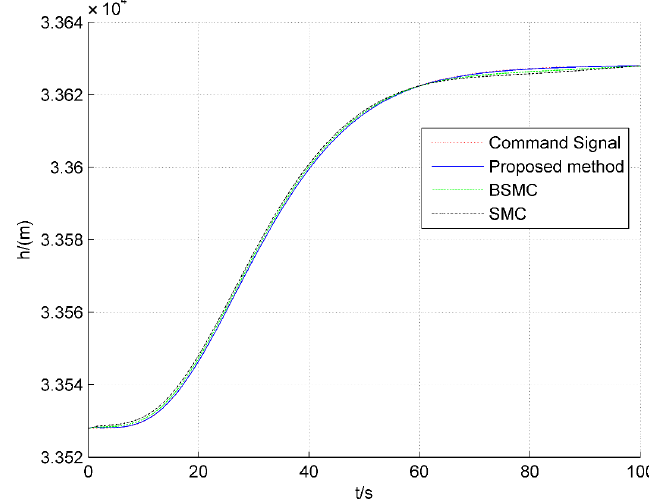
Figure 5. Tracking errors of velocity. ×